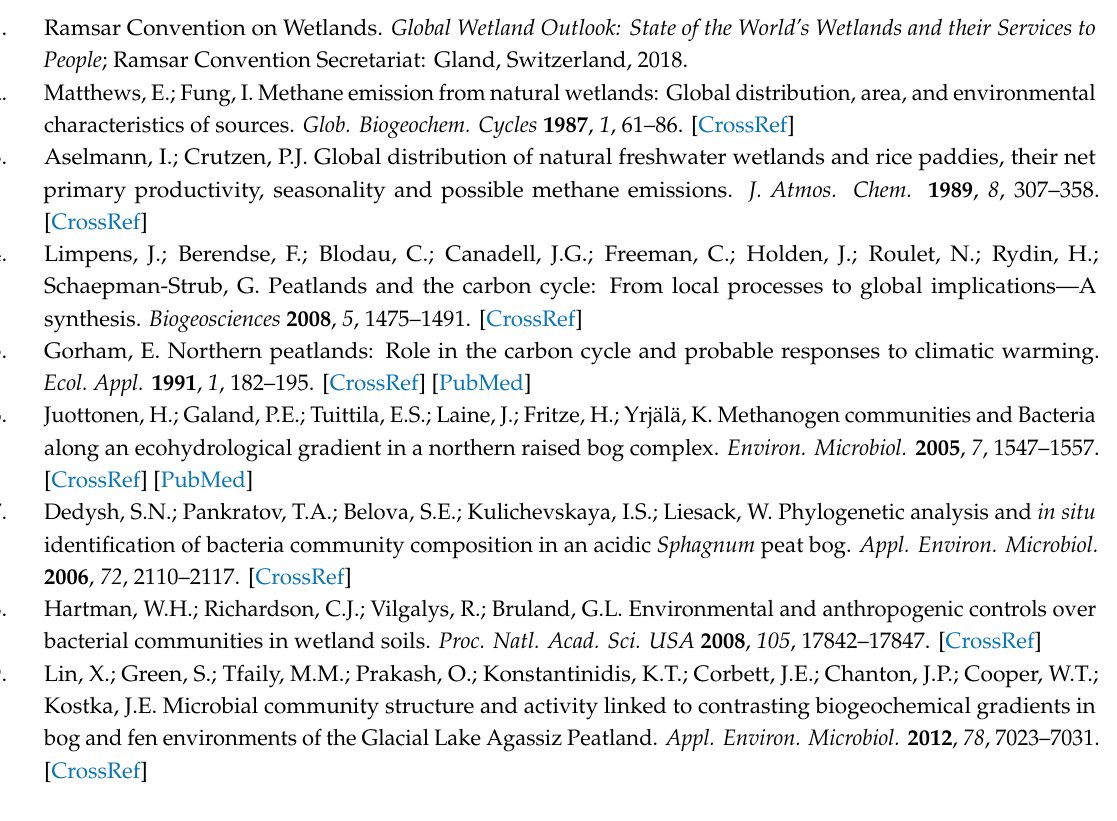
Figure S1: The mire Shichengskoe; Figure S2: The mire Piyavochnoe; Figure S3: The most representative microbial groups in the bog and fen sites of the Piyavochnoe mire; Table S1: Plant community composition of the sampling